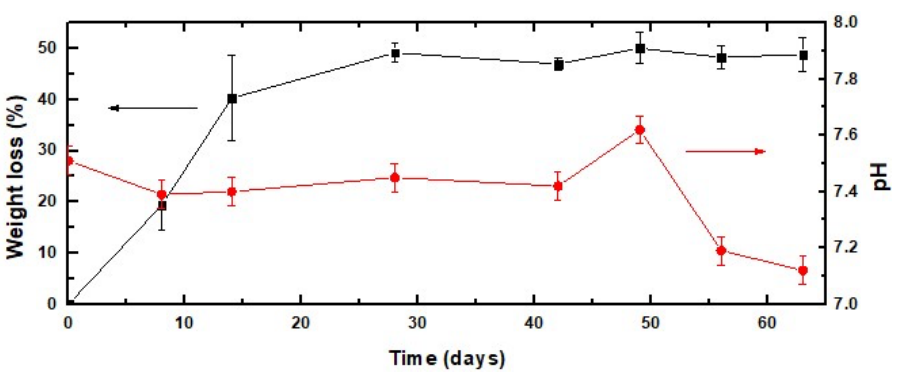
Figure 6. Weight loss (- (cid:4) -) of the SG40TCP60 material in PBS and pH evolution (- (cid:4) -) of the solution for 9 weeks.